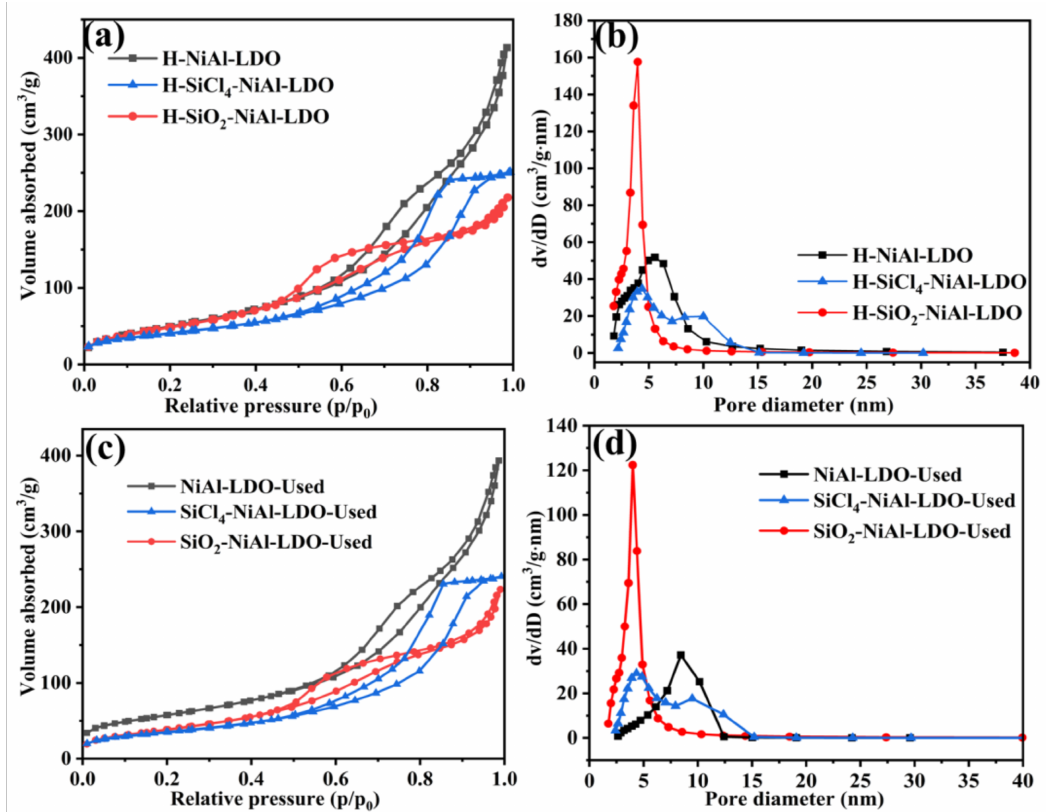
Figure 4. Nitrogen adsorption-desorption isotherms of ( a ) reduced samples and ( c ) used samples; Pore size distribution of ( b ) reduced samples and ( d ) used